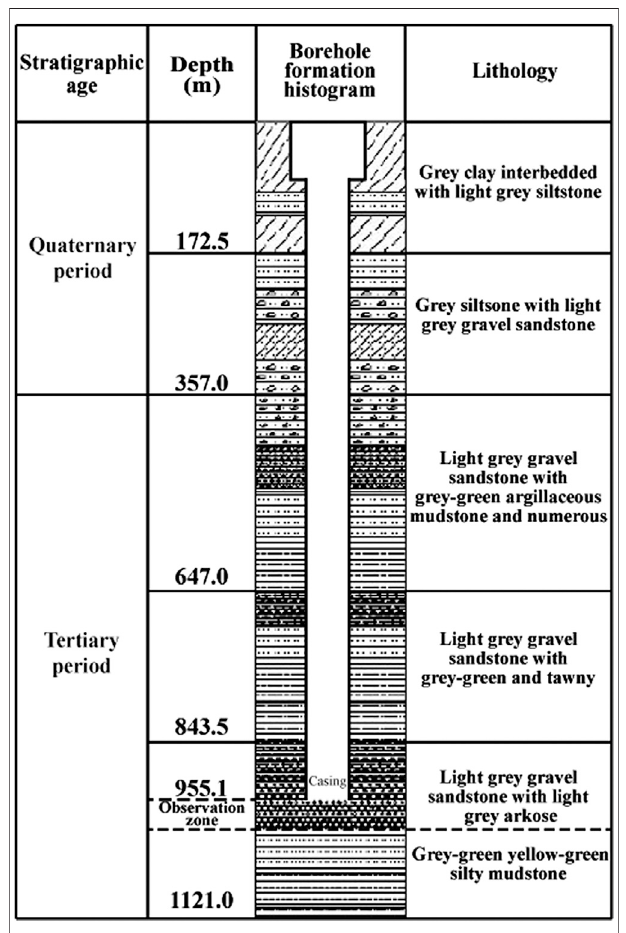
FIGURE 2 | Lithological cross-section of the Panjin observation